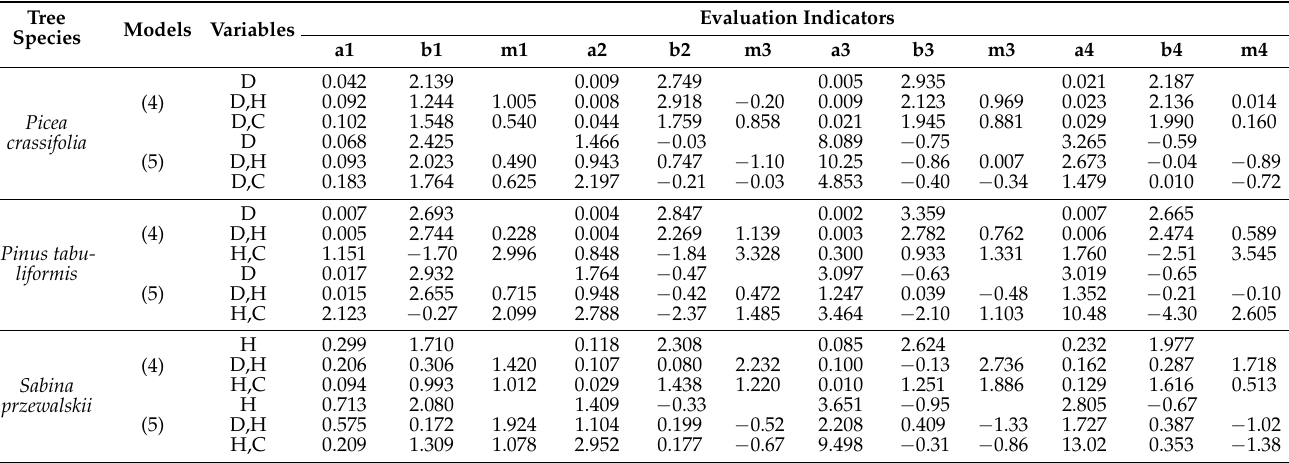
Table 4. Parameter values of the two compatible models estimating the total biomass and biomass of each component of three tree